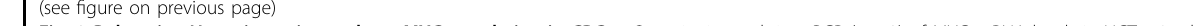
Fig. 3 Polyamine-Hypusine axis regulates MYC translation in CRC. a Quantitative real-time PCR ( n = 3) of MYC mRNA levels in HCT116 cells treated with 100 μ M GC7 for the indicated times. Data were normalized using L32 mRNA. b HCT116 cells were treated with 100 µM GC7 or vehicle for 24 h and incubated with 100 μ g/mL CHX for the indicated times. Immunoblottings were performed with the indicated antibodies. Vinculin, loading control. Densitometric analysis of MYC/Vinculin protein levels is shown at the bottom of each lane. c HCT116 cells were transduced with lentiviruses expressing shEIF5A or SCR for 72 h and selected with puromycin. Endogenous polyamines were depleted by incubating the cells with 1 mM DFMO for 3 days. Polyamine-depleted cells were treated with 10 μ M Putrescine (PUT) or 10 μ M Spermidine for 4 h. Immunoblottings were performed with the indicated antibodies. Vinculin, loading control. d MYC mRNA levels from c . Data were normalized by L32 mRNA; results are represented as fold change ( n = 3). e HCT116 cells were depleted of polyamines as above and treated with 10 μ M Spermidine (SPD) for 16 h. CHX (100 μ g/ml) was added for the indicated time points. Staining for MYC protein levels is shown. Vinculin, loading control. Densitometric analysis of MYC/Vinculin protein levels is shown at the bottom of each lane. f RNA IP. HCT116 cells were crosslinked, lysed, and immunoprecipitated with antibody anti EIF5A or control IgG. After elution, MYC mRNA levels were analyzed by RT-QPCR. Data were normalized by L32 mRNA levels ( n = 3). g Polysome pro fi les of DHPS-de fi cient and control (SCR) HCT116 cells. Cytoplasmic lysates were fractionated on 15 – 50% sucrose gradients. The graph shows ultraviolet (UV) absorbance at 260 nm of the different polysomal fractions ( n = 3). h QPCR analysis of MYC mRNA loaded in the different polysome fractions, β -actin was used to normalize the values ( n = 3). i Western blotting showing total MYC protein levels in the lysate used for polysomal fractionation. β -Actin, loading control. For Statistical analysis: ns not signi fi cant, * p < 0.05, ** p < 0.01, *** p < 0.001, by Student ’ s t -test. Data represent the mean ± SD of experiments performed in triplicates and repeated at least three